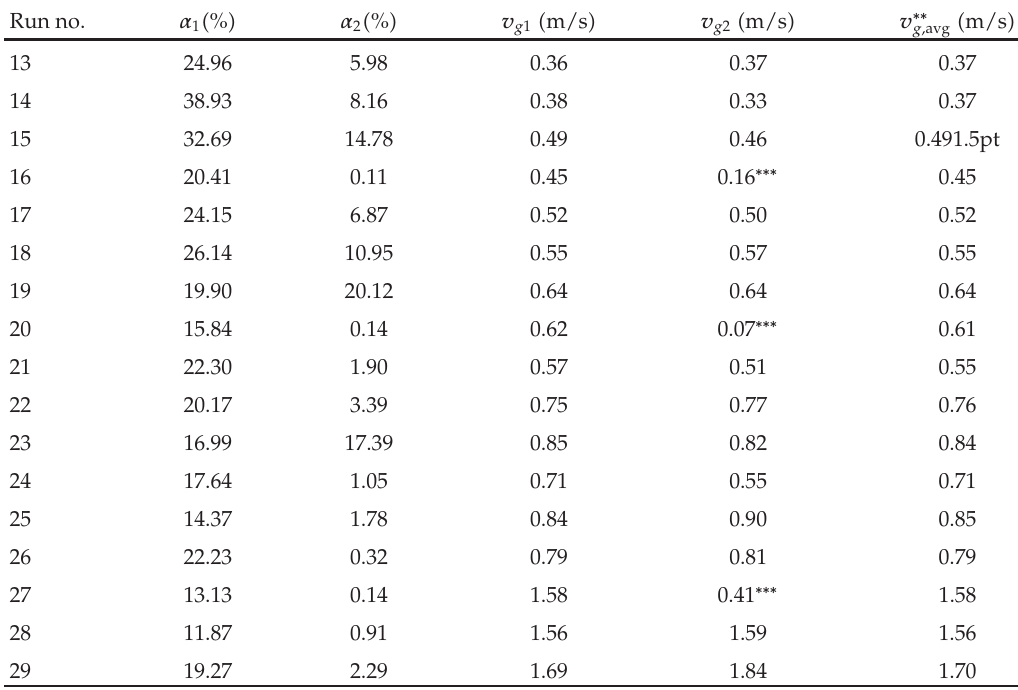
Table 1: Area-averaged data for Runs 13–29 at L/D h (cid:8) 13 (cid:4) 9 (cid:5) ∗ . Run